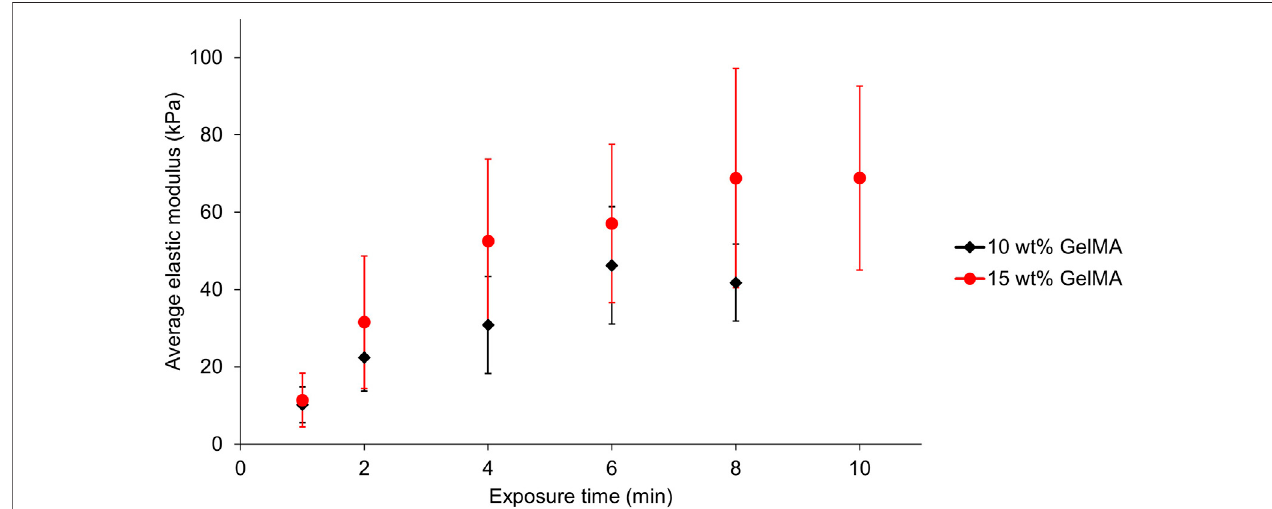
FIGURE 2 | AFM force indentation measurements of the average elastic moduli of 10 wt% (black diamond) and 15 wt% (red circle) GelMA hydrogels as a function of their exposure time to the green LED. The error bars represent the standard error (10 wt%: between 15 and 21 force maps over four separate gels for each exposure time; 15 wt%: between 27 and 31 force maps over seven separate gels for each exposure